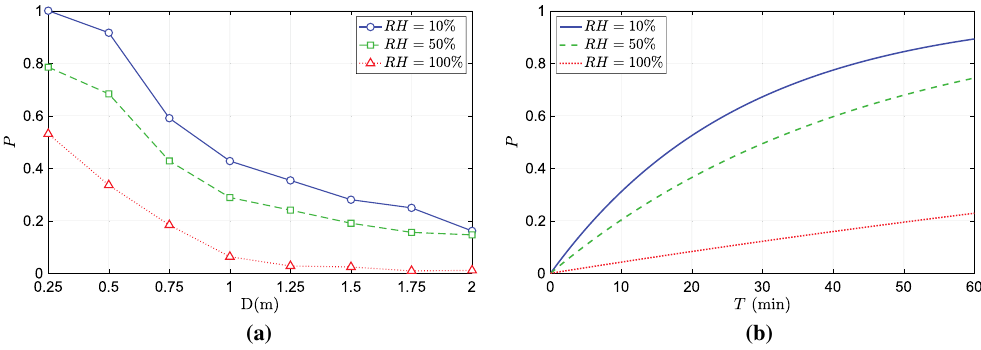
Figure 12. ( a ) Variation of infection probability over ( a ) distance from the infection source, and ( b ) time of exposure under different humidity